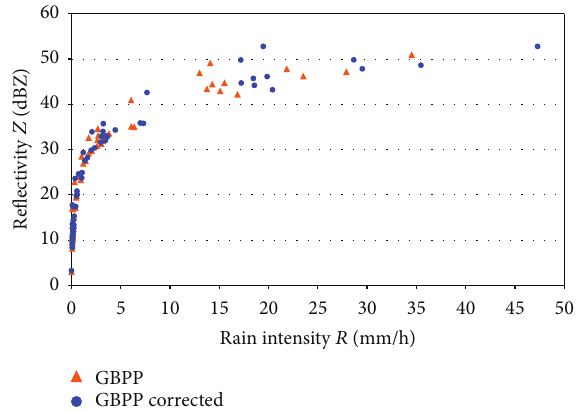
Figure 13: 𝑍 - 𝑅 relationship calculated with the sampling area un- corrected ( GBPP ) and corrected ( GBPP corrected